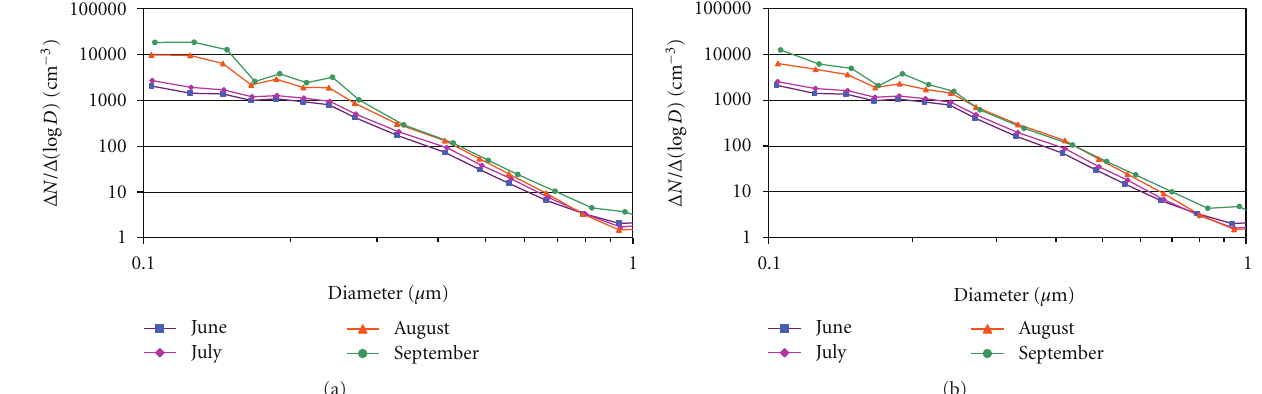
Figure 6: Mean size distributions in the months of June, July, August, and September 2000 in (a) the measurements registered with wildfires and in (b) measurements not contaminated by wildfires. Only the sizes between 0.1 and 1 μ m are